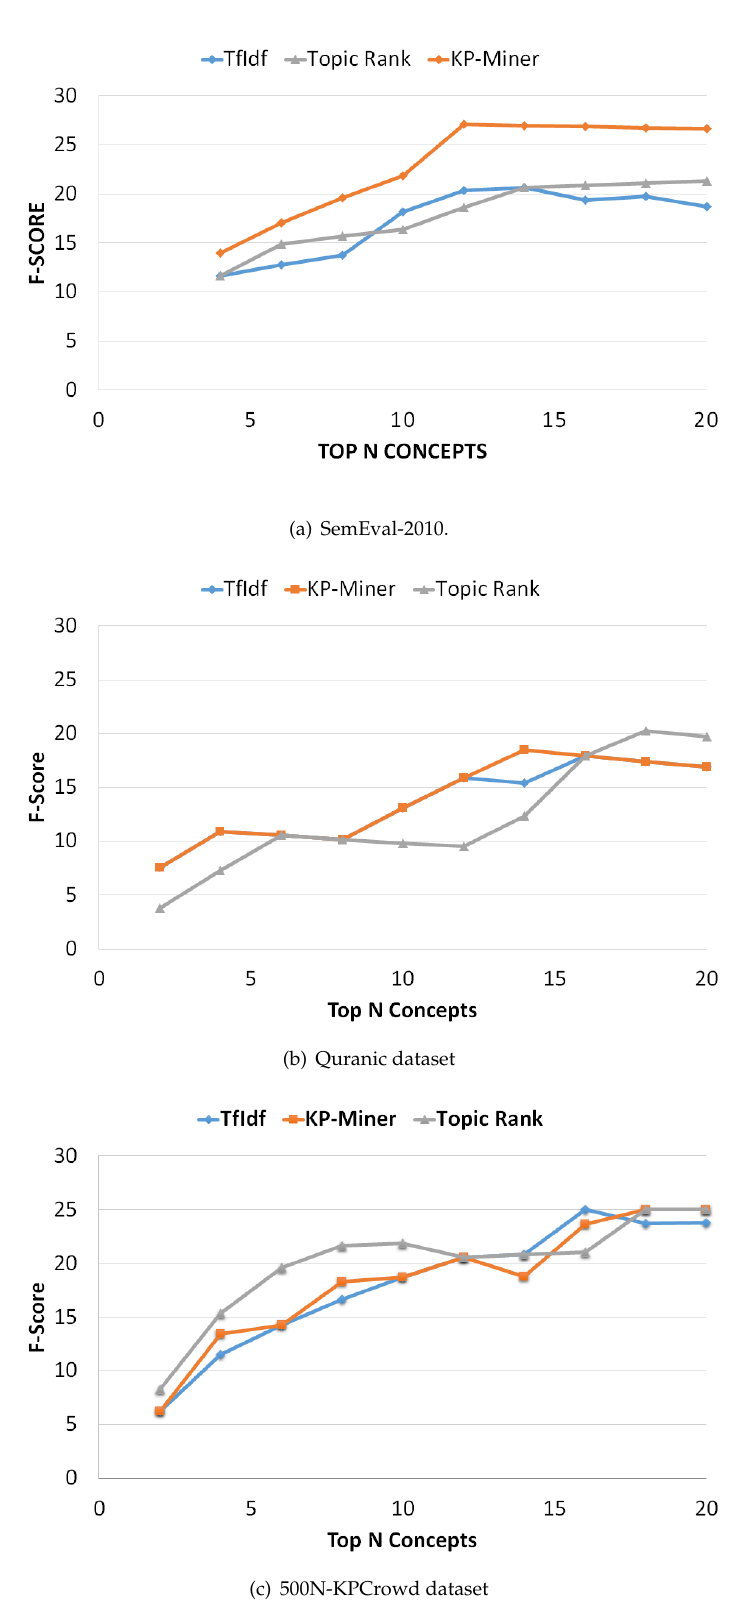
Figure 4. F-measure curves for selected